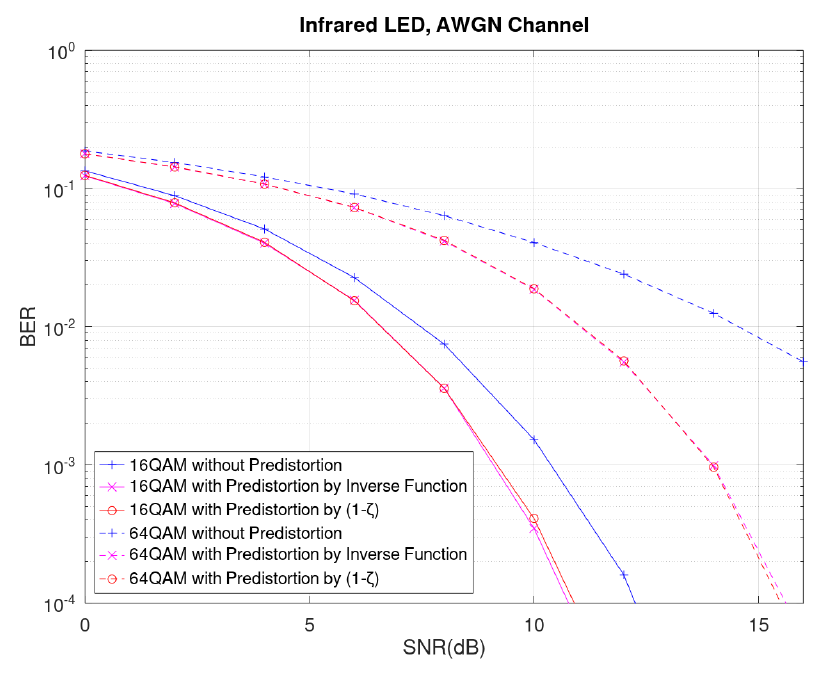
Figure 9. BER performances of the predistortion in 16/64 QAM modulation for infrared